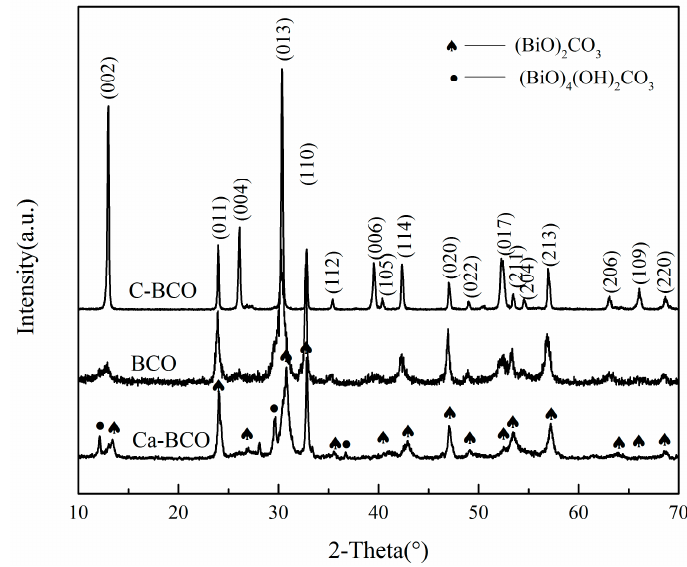
Figure 1. XRD patterns of as-synthesized (BiO) 2 CO 3 nanoplates (C-BCO), as-synthesized (BiO) 2 CO 3